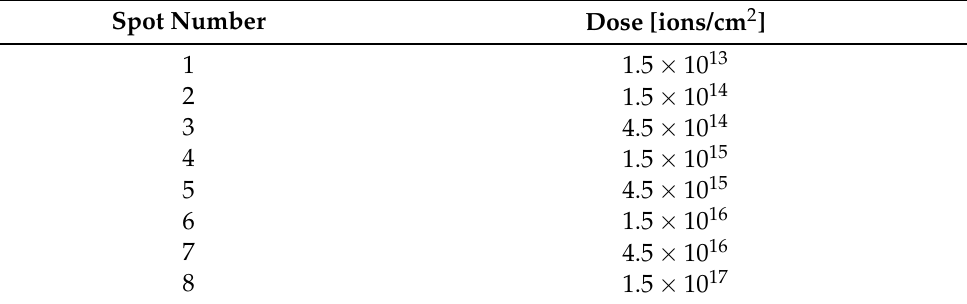
Table 1. Proton–dose values of all implanted